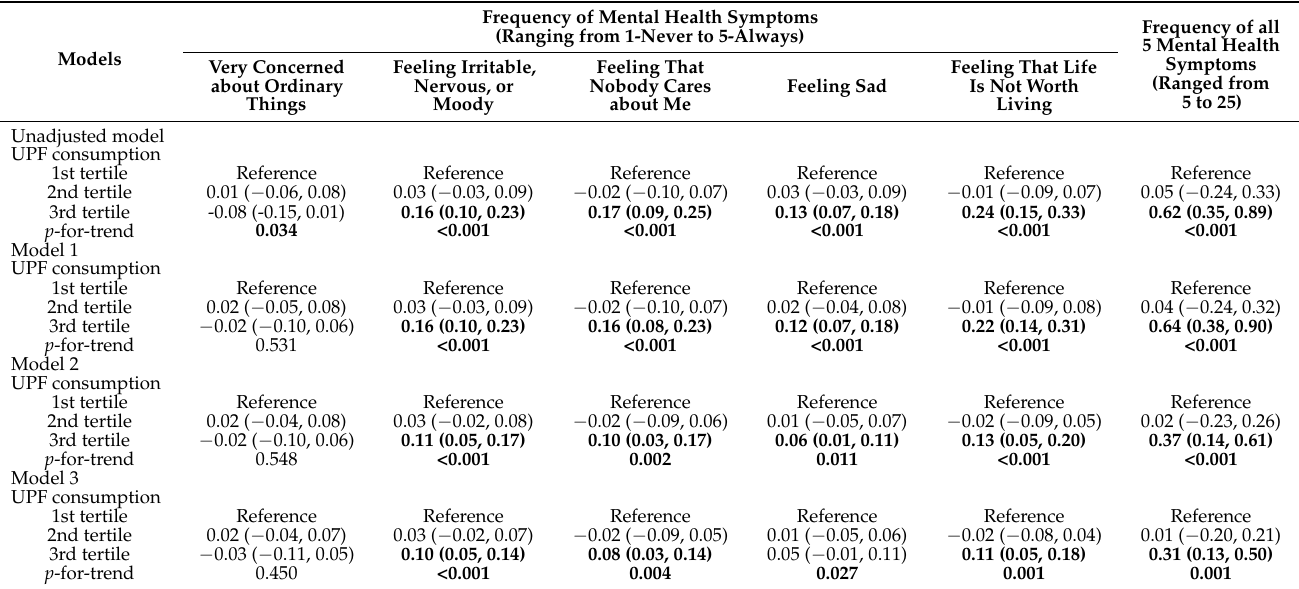
* Values are ß -coefficients (95% confidence intervals) obtained through generalized linear models. Values in bold indicate statistically significant results ( p < 0.05). Model 1: adjusted by age (>15 vs. 13–15 years), self-reported race (white vs. nonwhite), socioeconomic condition (lower [1st quartile] vs. moderate or higher [2nd to 4th quartiles]), school location (urban vs. rural), school administration (public vs. private), and educational level (secondary vs. primary). Model 2: previous model adjusted by parental living (both parents vs. one or no parent), having meals with parents (always or almost always vs. lower frequency), number of close friends ( ≥ 3 vs. <3),